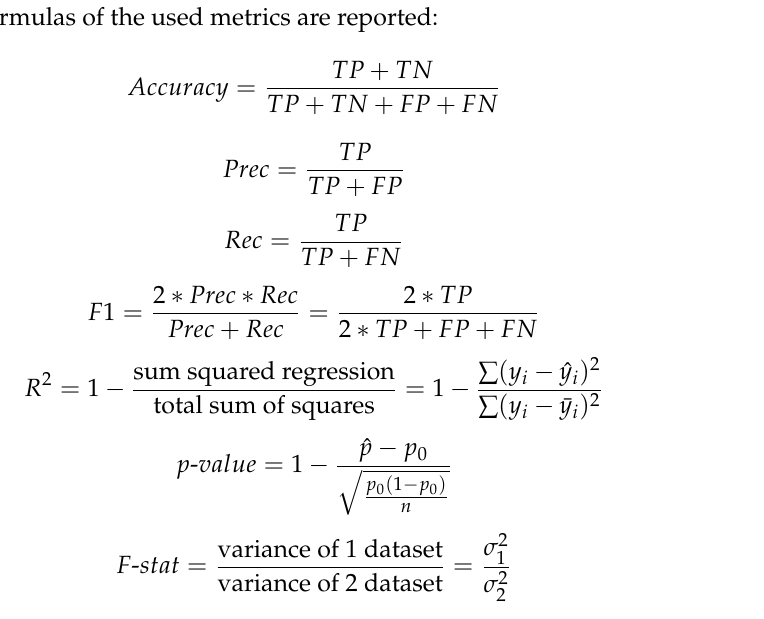
Figure 2. Flowchart of the modelling